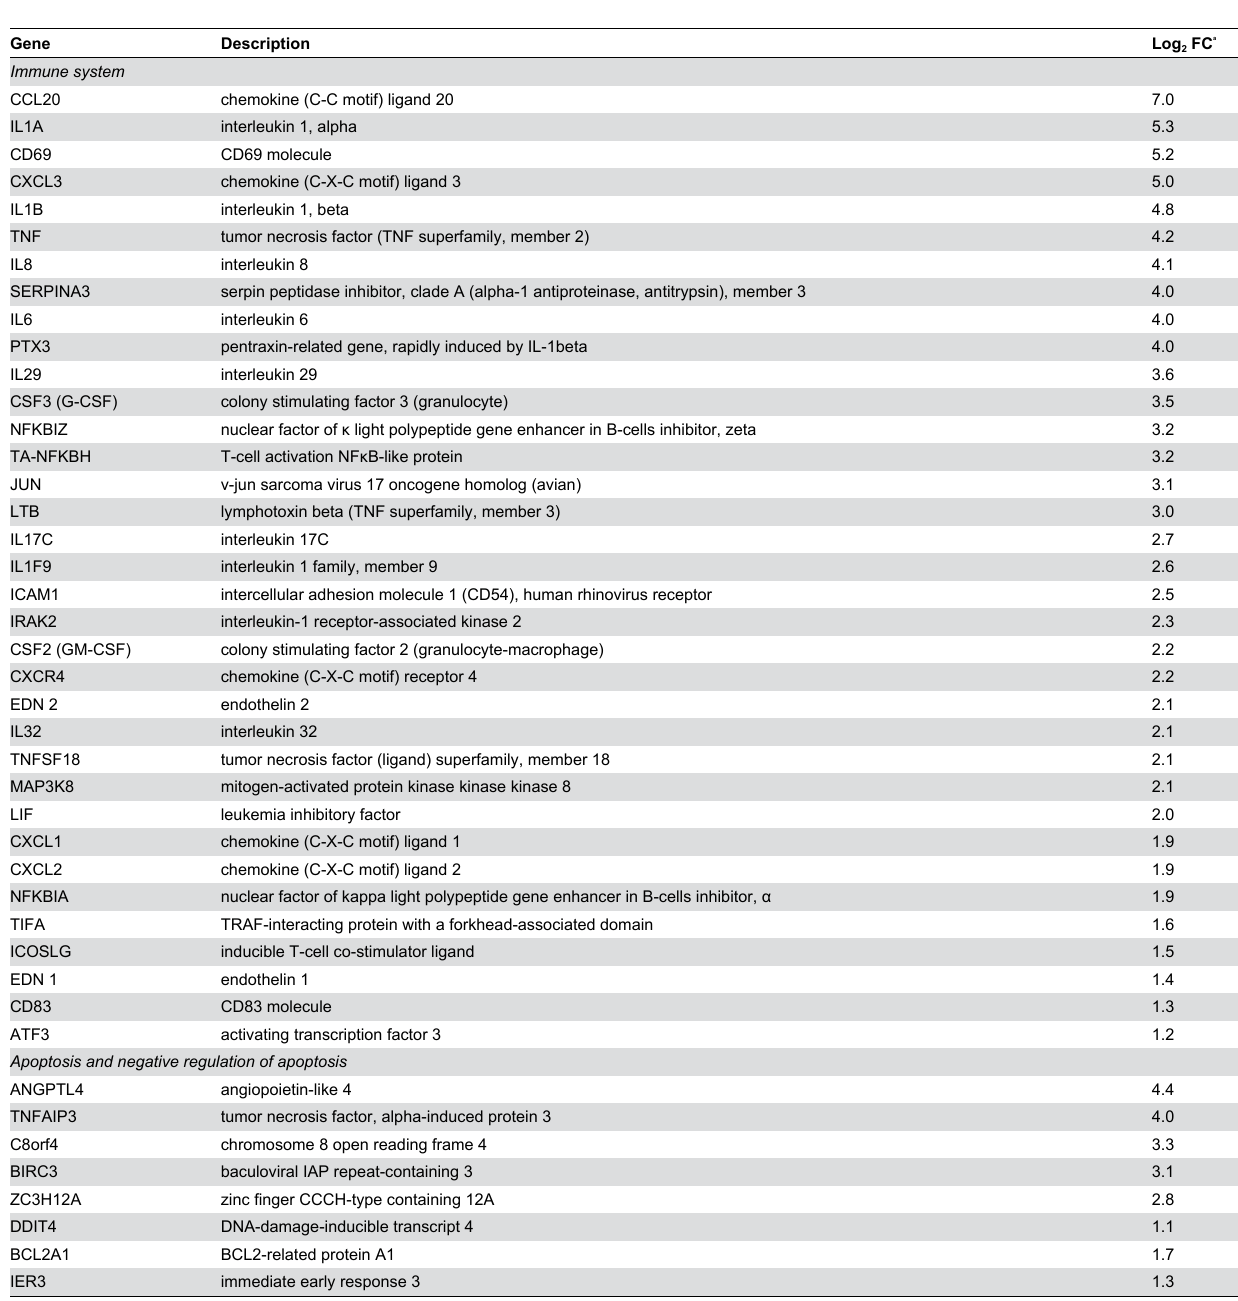
Table 2. Selection of Detroit 562 genes induced in response to M. catarrhalis BBH18.